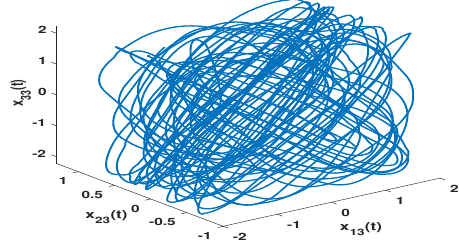
Figure 3. The chaotic trajectories of x i 3 ( t ) .